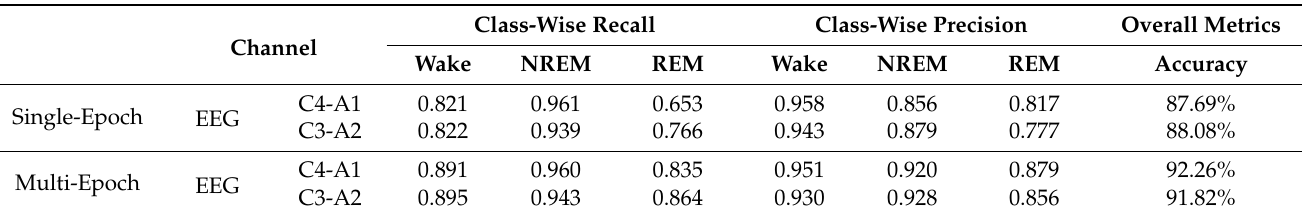
Table 9. Performance accuracy of a single-channel EEG-based deep learning model based on a public SHHS